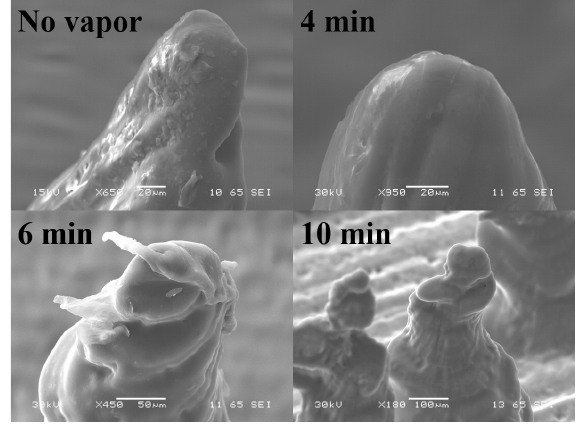
Figure 7. Effect of acetone vapor polishing of the 3D printed microneedles. These MNs were printed at the optimum value of 45°—( a ) No vapor polishing; ( b ) polishing for 4 min; ( c ) polishing for 6 min and ( d ) polishing for 10 min.